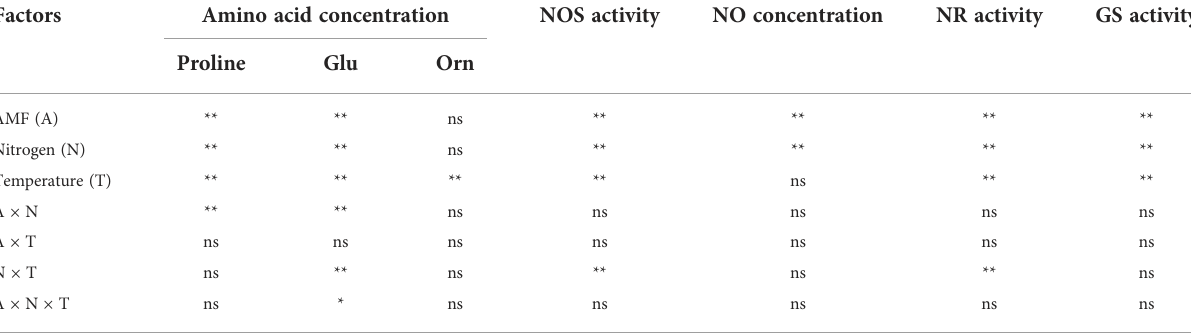
TABLE 4 Results of multiway ANOVA for analyses of differences in amino acid concentration, NO concentration and enzyme activities in experiment 2.